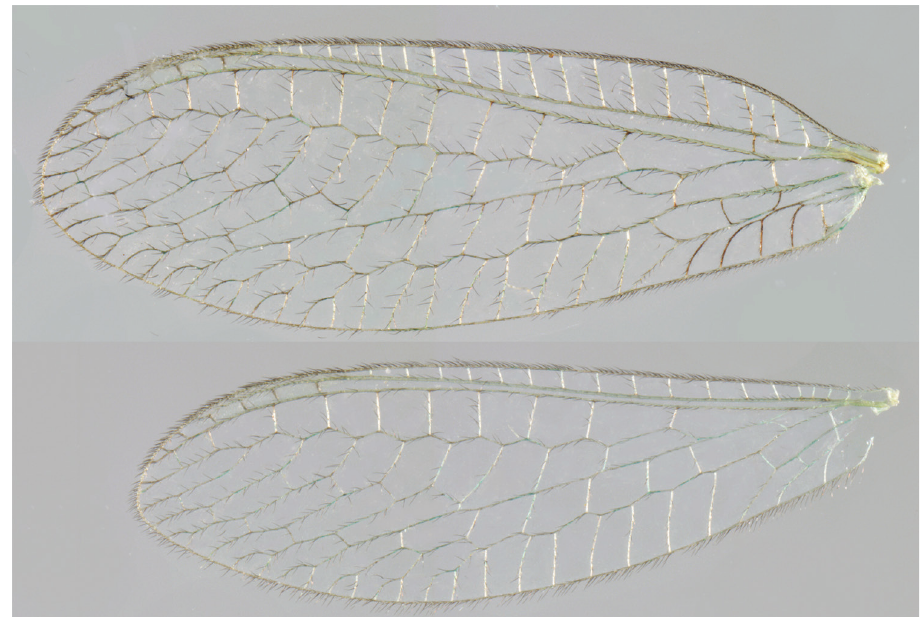
Figure 117. Ungla chacranella (Banks): Wings (Argentina, La Rioja, male, FSCA).